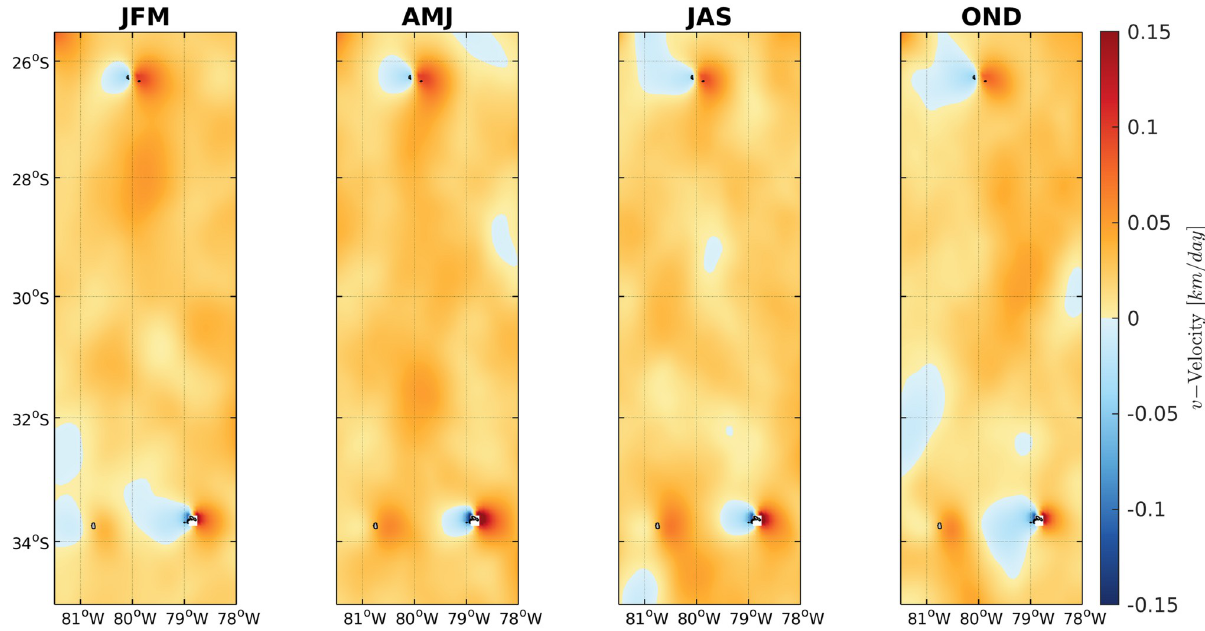
Fig 5. Seasonal (JFM, summer; AMJ, fall; JAS, winter; OND, spring) meridional (positive, northward; negative, southward) velocities averaged over the first 100 m between Juan Fernandez Archipelago and the Desventuradas Islands, 25.5–35˚S and 81.5–78˚W. Data was obtained with Copernicus model products freely distributed by CMEMS (http://marine.copernicus.eu/).